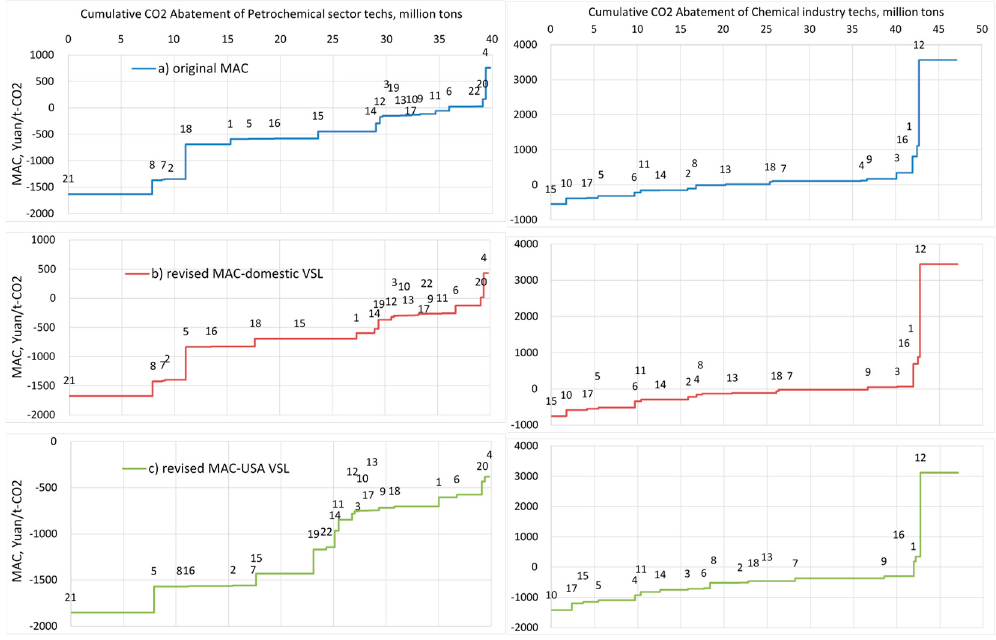
Figure 8. MACC in petrochemical and chemical industry.